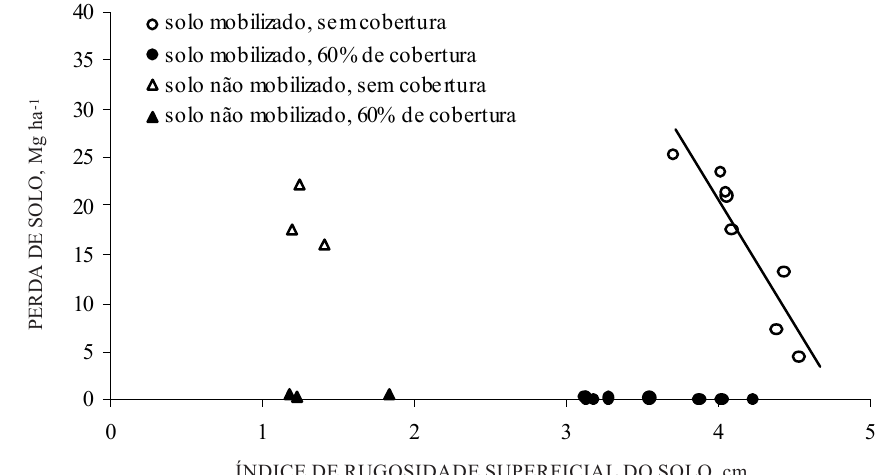
Figura 7. Relação da perda de solo com o índice de rugosidade superficial do solo nos tratamentos estudados.